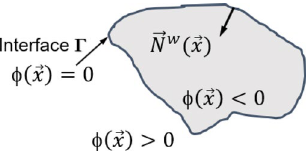
x ) : φ( x ) 0 locates on the interface Γ with inward normal = (cid:31) �